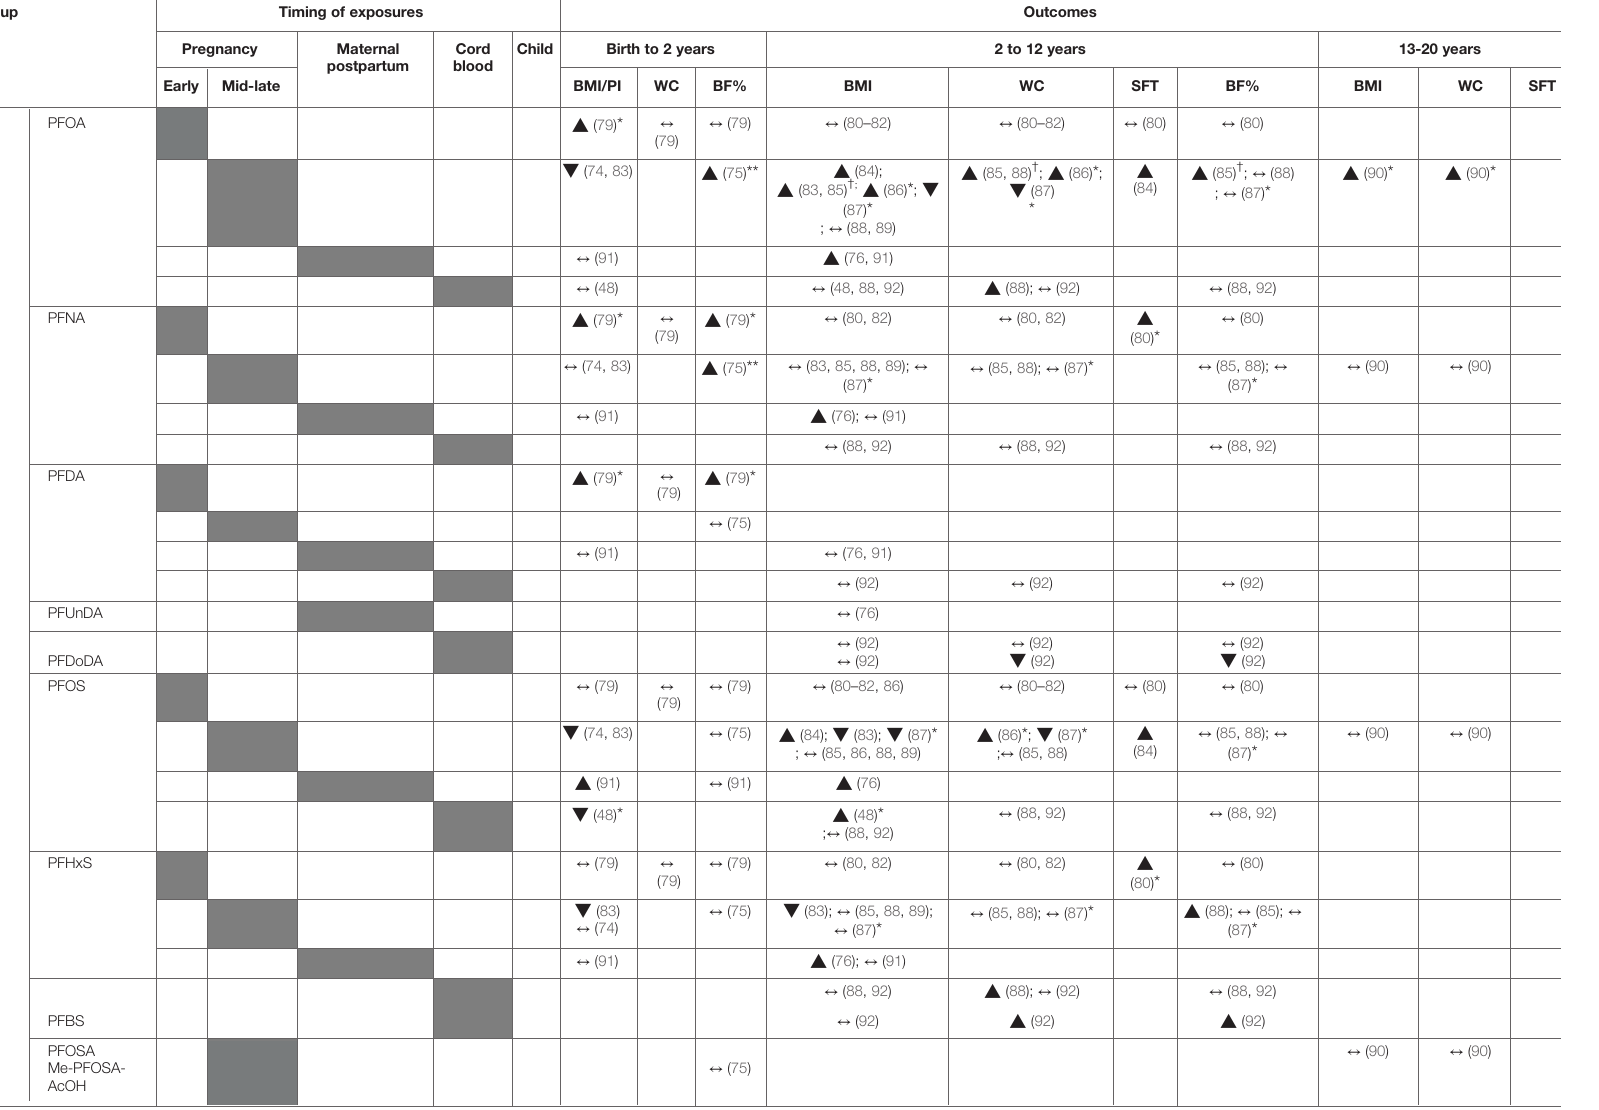
TABLE 3 | Summary of studies assessing associations between PFAS exposure and adiposity